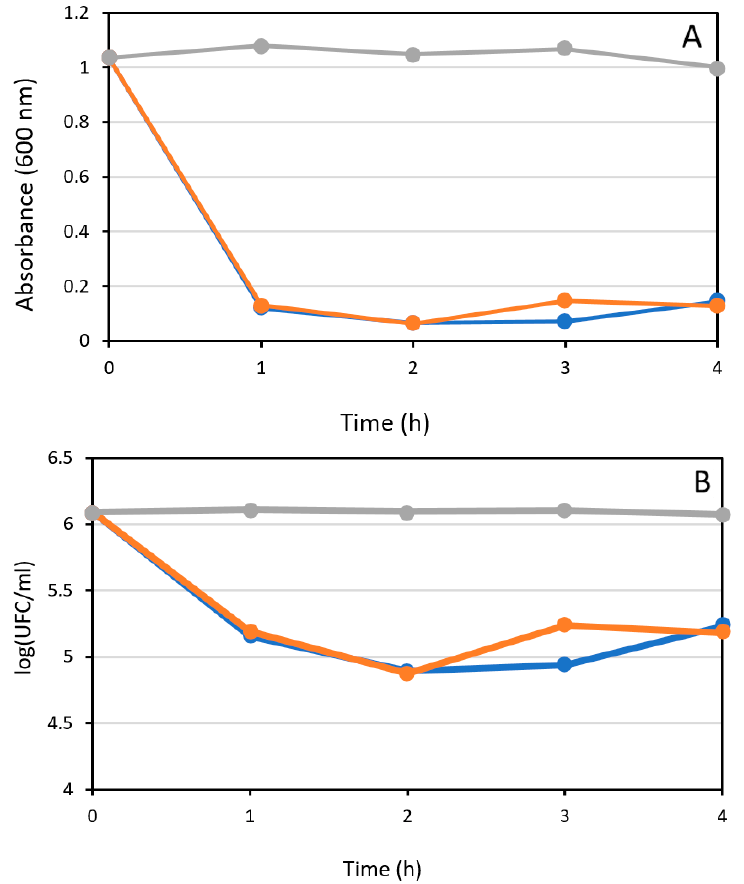
Figure 10. Adsorption kinetics of Salmonella on saponite and sap-PCH measured in absorbance ( A ) and concentration ( B ). The three treatments are: control (grey line), saponite (blue line) and saponite-PCH (orange line).